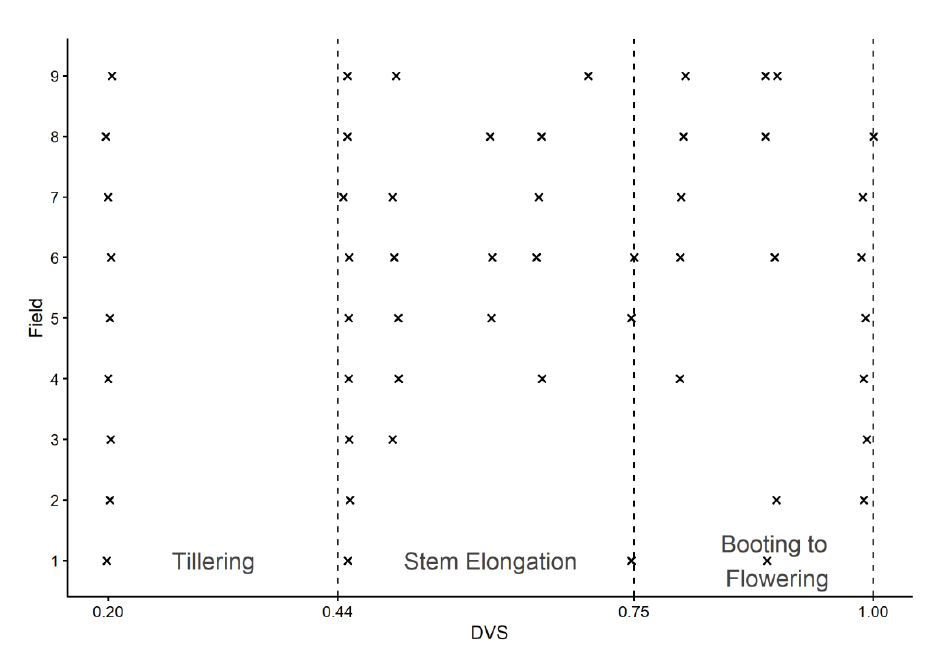
Figure 1. Available cloud-free Sentinel-2 images per field for leaf area index (LAI) estimation, with the acquisition dates converted to development stages (DVS) of winter wheat. A cross indicates each available image ( × ). DVS 0.2: beginning of tillering; 0.5: beginning of stem elongation; 0.9: beginning of heading; 1: full flowering. Dashed vertical lines represent phenophase ranges.